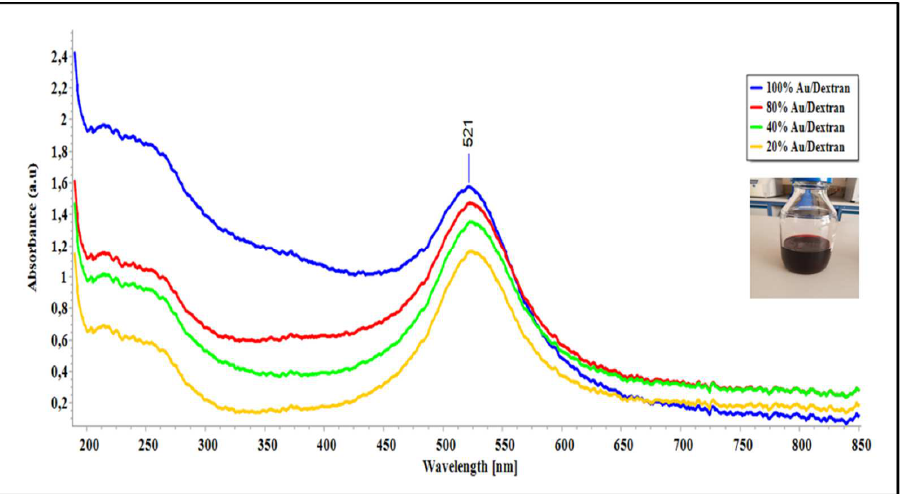
Figure 2. UV-Vis spectra of gold/dextran nanoparticles at 100%, 80%, 40% and 20% concentration. Spectra were obtained using an insert: actual image of the nanoparticles. Spectra were obtained using an insert: actual image of the